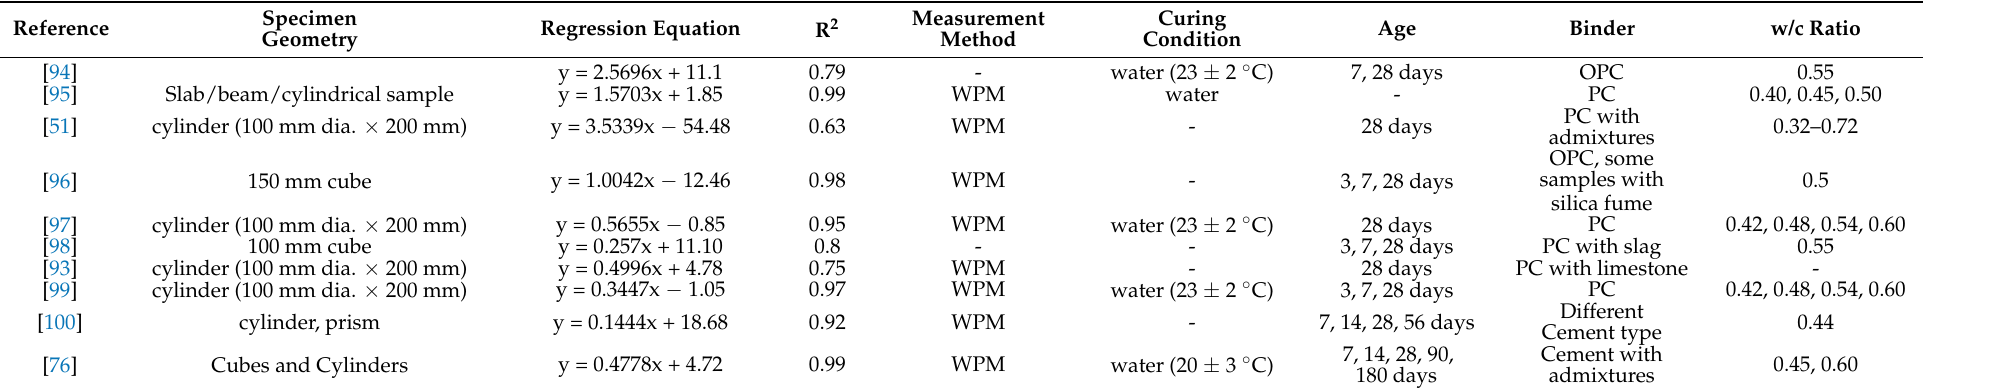
Table 4. Details of Specimens used from different references for the correlation of electrical resistivity and compressive strength, including the specimen geometry, regression equation, measurement method, curing condition, age, type of binder, and w/c